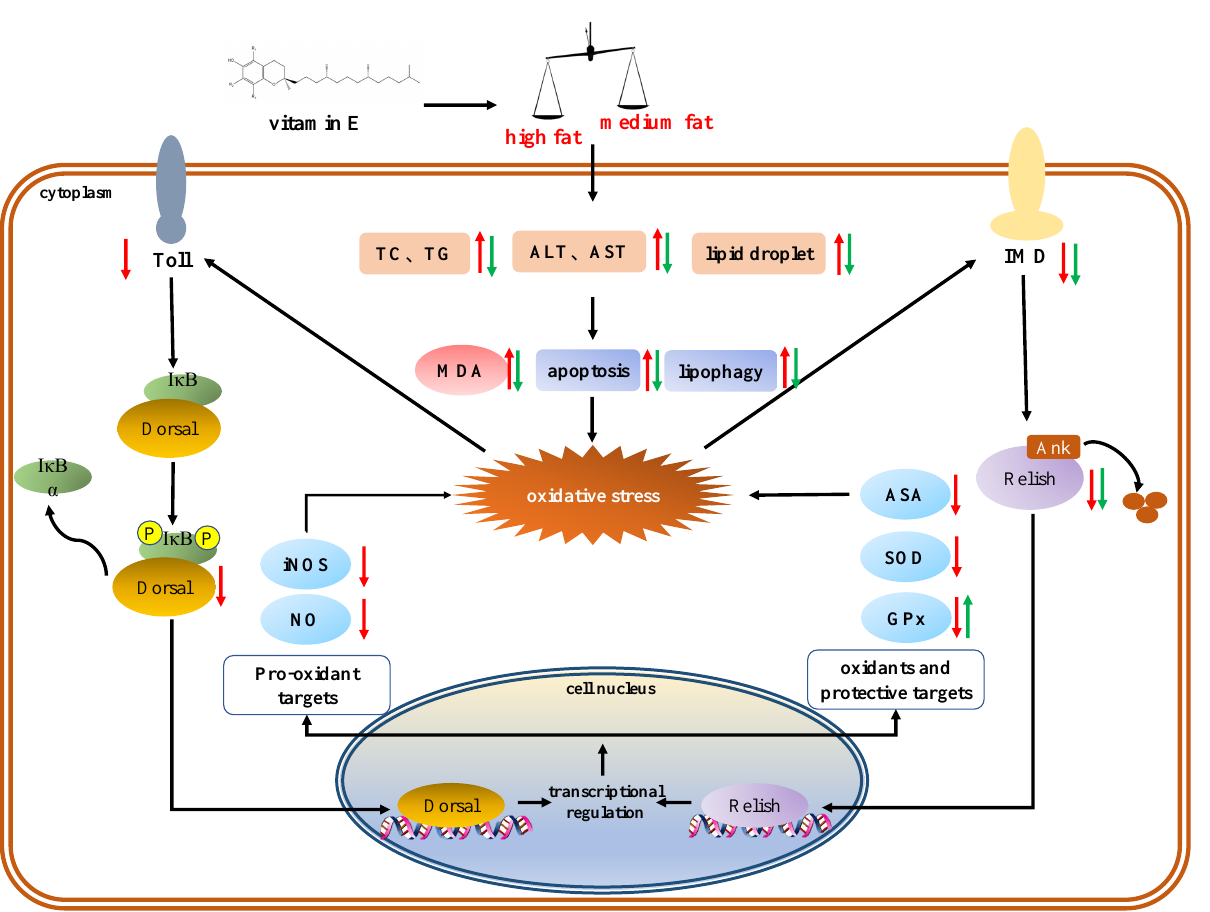
Figure 11. NF- κ B/NO signaling mechanism in response to dietary high fat and VE. The red arrows indicate the effects of high fat; the green arrows indicate the effects of